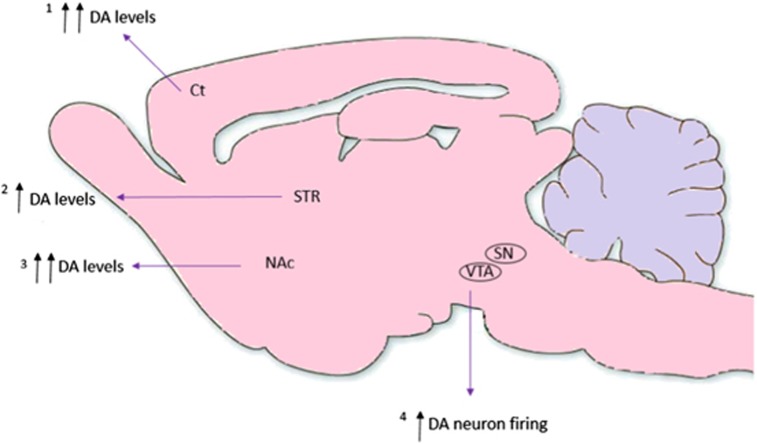
Showing the location of the major dopaminergic findings following acute ketamine administration from our meta-analyses and qualitative review. 1Meta-analysis finding with effect size of 1.33 [95% CI, 0.81-1.85 p<0.001]. 2Meta-analysis finding with effect size of 0.57 [95% CI, 0.05 – 1.10 p< 0.05]. 3Meta-analysis finding with effect size of 1.30 [95% CI, 0.14 – 2.45 p< 0.05]. 4Found in the acute studies to measure this to date (Supplementary Table 3). Arrows denote the relative increases in dopamine levels in each region of interest.